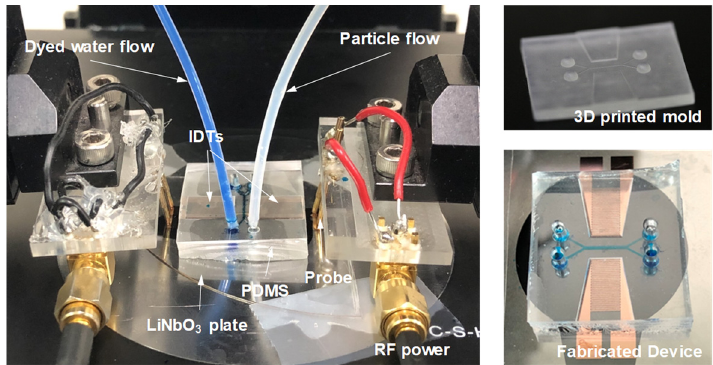
Figure 2. Photographs of the experimental setup, 3D-printed monolithic master mold, and Lamb- wave acoustofluidic device.